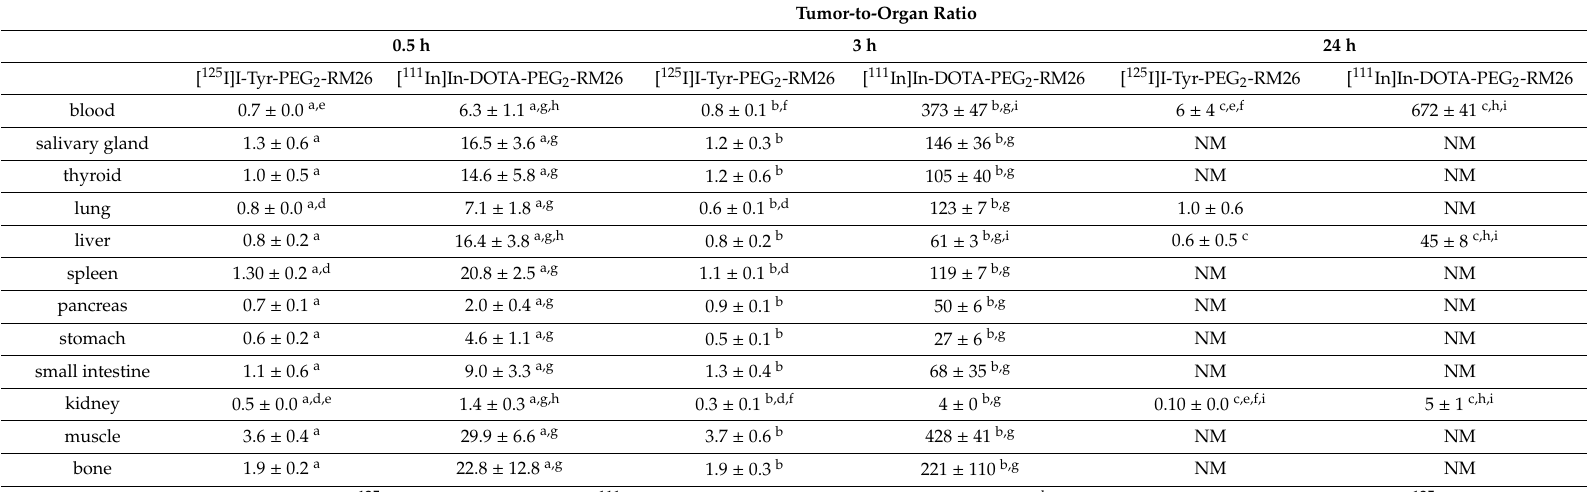
Table 2. Tumour-to-organ ratios of [ 125 I]I-Tyr-PEG 2 -RM26 and [ 111 In]In-DOTA-PEG 2 -RM26 in BALB / C nu / nu mice bearing GRPR-expressing PC-3 tumour xenograft at 0.5, 3 and 24 h after injection ; (Mean ± SD; n = 4), NM stands for